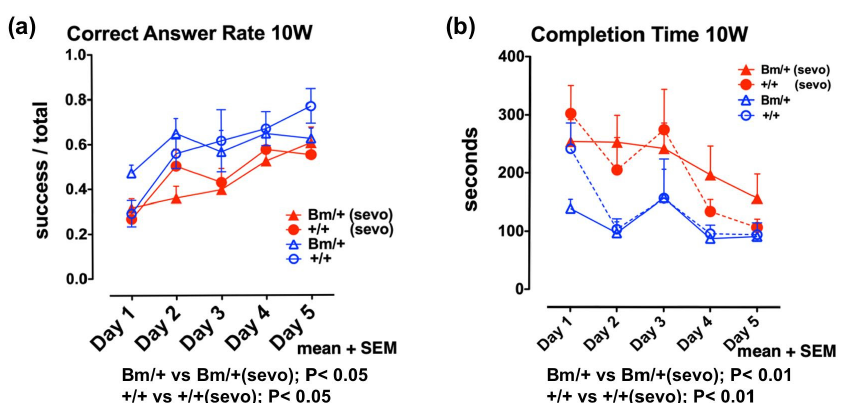
Figure 2. Anesthetic exposure during the perinatal period had negative effects on spatial working memory in young mice. Eight-arm radial maze testing was performed in wild-type mice ( +/+ ; circles) and Bip mutant mice (Bm; triangles) at 10 weeks after sevoflurane exposure ( +/+ sevo, n = 12, closed red circles; Bm /+ sevo, n = 16, closed red triangles), and without exposure ( +/+ , n = 6, open blue circles; Bm /+ , n = 8; open blue triangles). Tests were performed for 5 days. Statistical significance was determined by one-way repeated measures analysis of variance (ANOVA) followed by Bonferroni’s multiple comparison testing. ( a ) Correct answer rates are shown as the mean value of each group + standard error of the mean (SEM). The correct answer rate was defined as the ratio of successful attempts to overall attempts (0.0–1.0). ( b ) Mean completion times for each group + SEM (data extracted from DATASET S1 and DATASET S2, Front. Neurosci. 12:753. doi:10.3389 / fnins. 2018.00753). Fetal anesthetic exposure resulted in a lower correct answer rate ( p < 0.05) ( a ), and a longer completion time ( p < 0.01) ( b ), compared with unexposed mice; this was the case for both Bip mutant mice and wild-type mice.